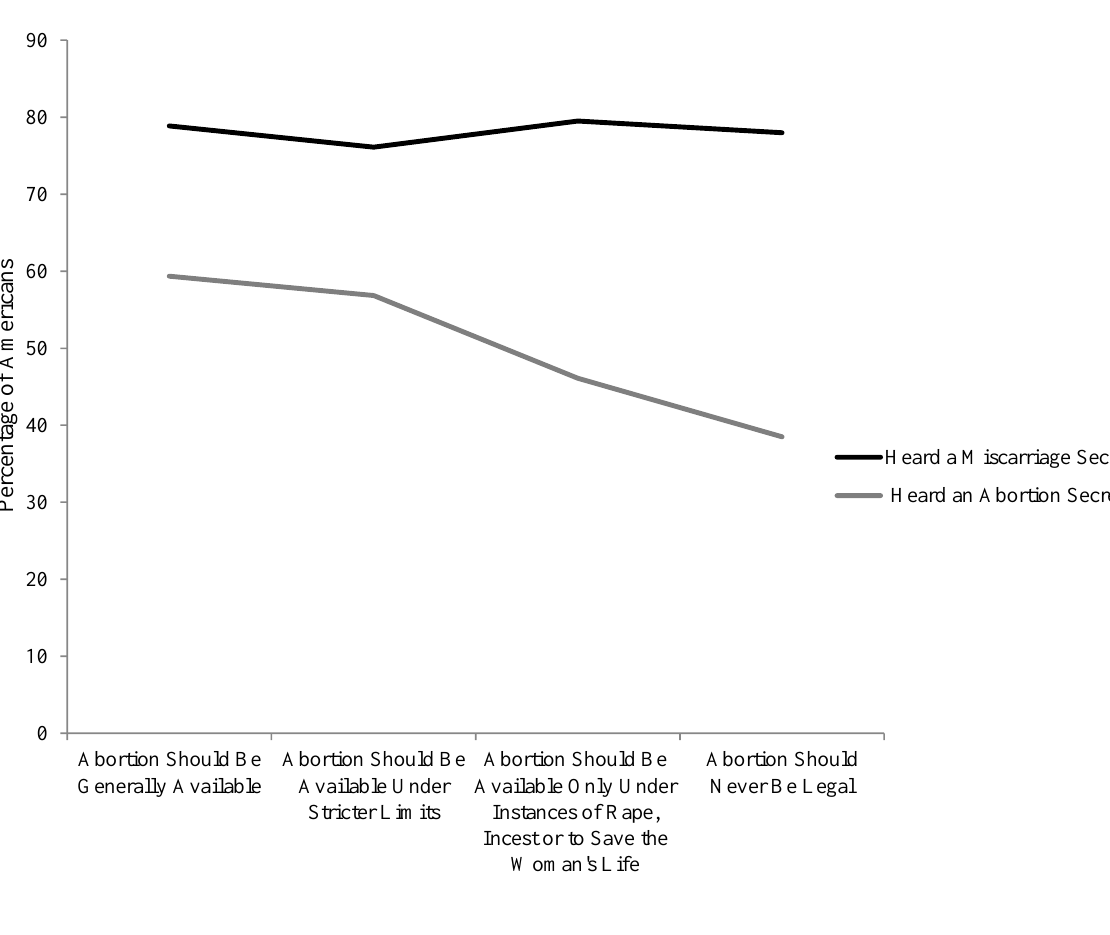
Figure 1: Percentage of Americans who have heard about someone else’s abortion and miscarriage by own attitude toward abortion legality. AMACS 2012. Note the full descriptive statistics of the rates by demographics are found in Appendix